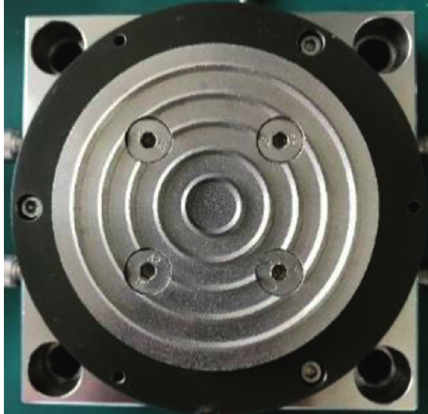
Figure 4: Ring-shape upheaval on bottom mould of VDDCSS.